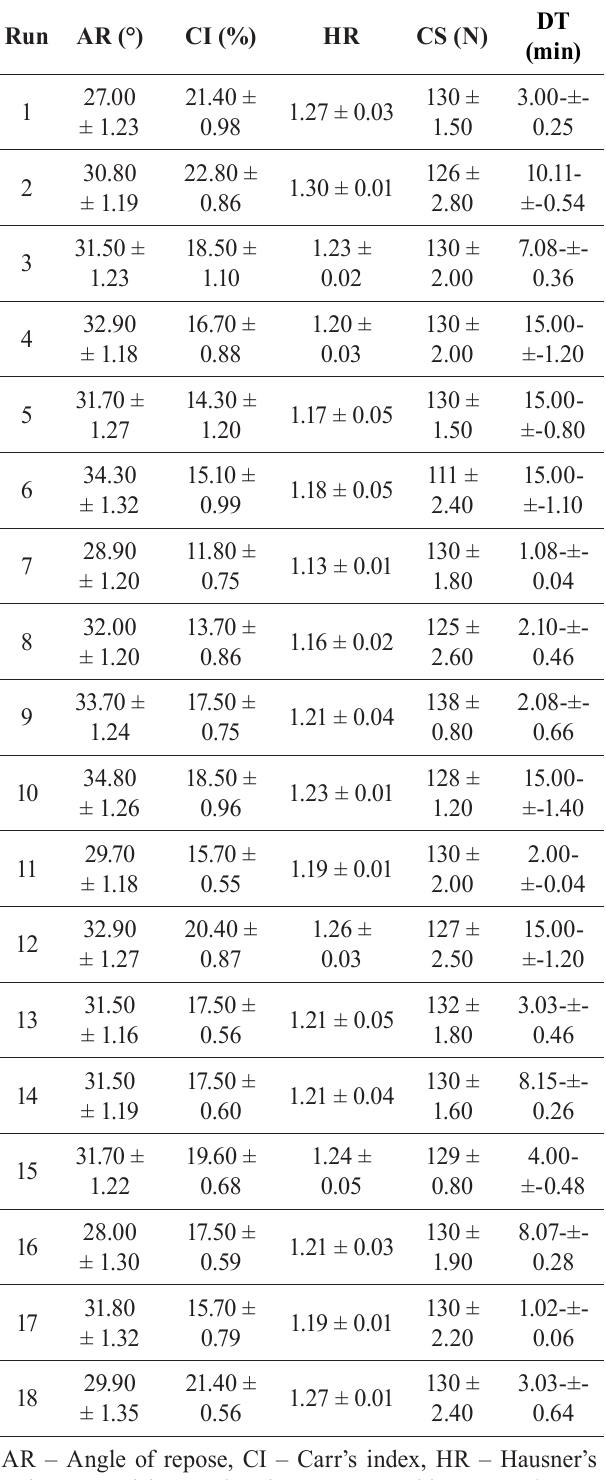
TABLE IV - Granule and tablet parameters of the preliminary